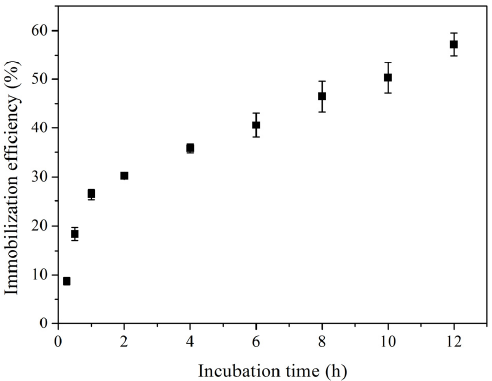
Figure 5. Immobilization efficiency as a function of incubation time. The immobilization was conducted using 1 g of polydopamine-coated Fe 3 O 4 nanoparticles and 20 mL of lipase QLM solution (10 mg/mL) at room